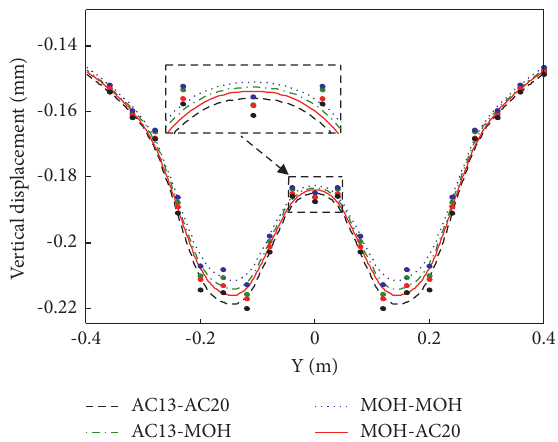
Figure 7: Instantaneous vertical displacement of the road surface at X �